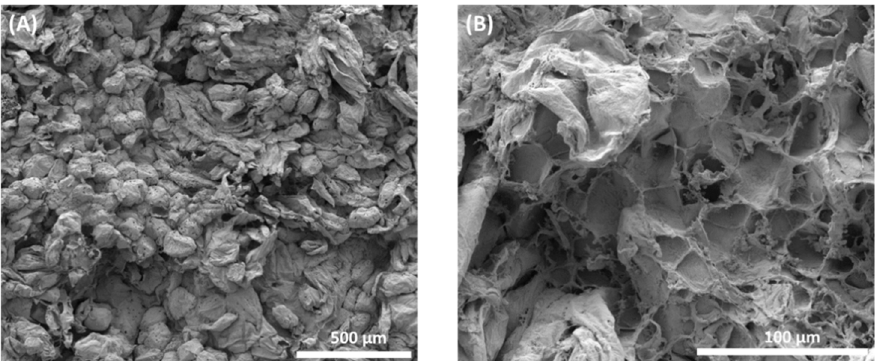
Figure 6. Microstructural analysis of osmotically dehydrated sapodilla. ( A ) General microscopic aspect of dehydrated sapodilla showing disordered cells; ( B ) areas of cell wall rupture.